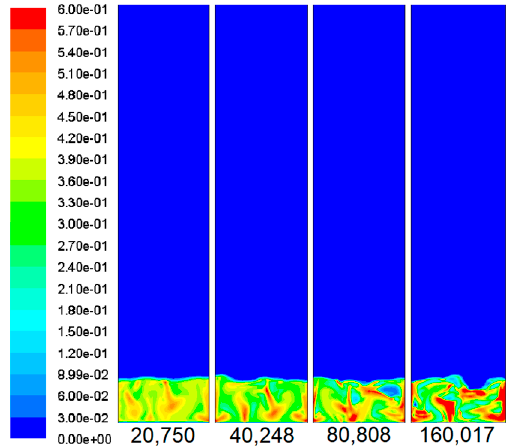
Figure 5. Instantaneous volume fraction contours for the simulation time of 3 s for each of the studied grids.